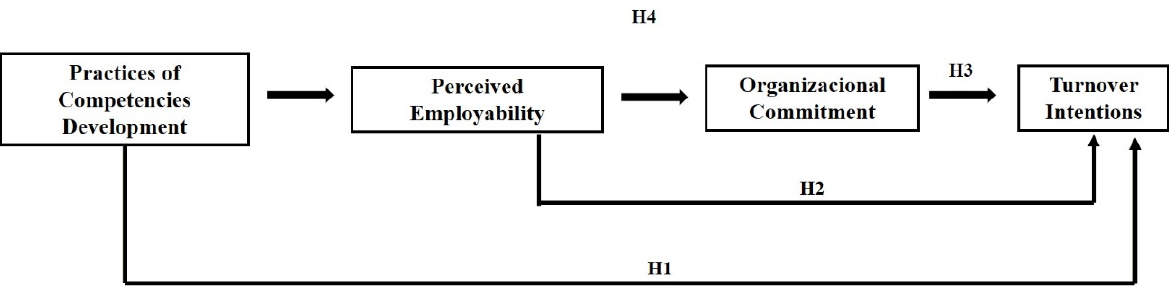
Figure 1. Research Model.